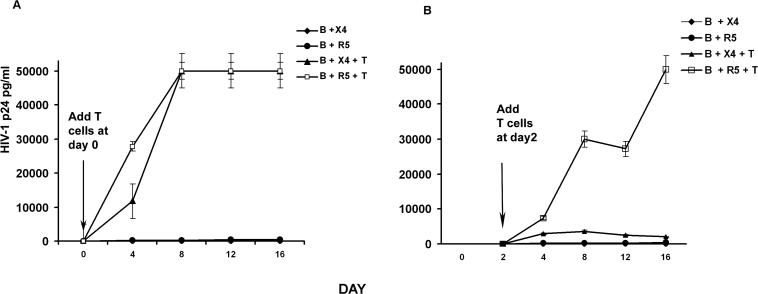
HIV-1 Is Maintained in an Infectious Form by B CellsActivated B cells were loaded with HIV-1 X4 (IIIb) or HIV-1 R5 (Ba-L) for 2 h at 37 °C, extensively washed and then either cultured immediately with autologous T cells (panel A) or incubated for 2 d prior to adding autologous T cells (panel B). B cells and T cells directly loaded with HIV-1 served as controls.